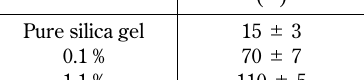
Table 3 Contact angle measure- ments ( (cid:155) ) for different par- ticulate